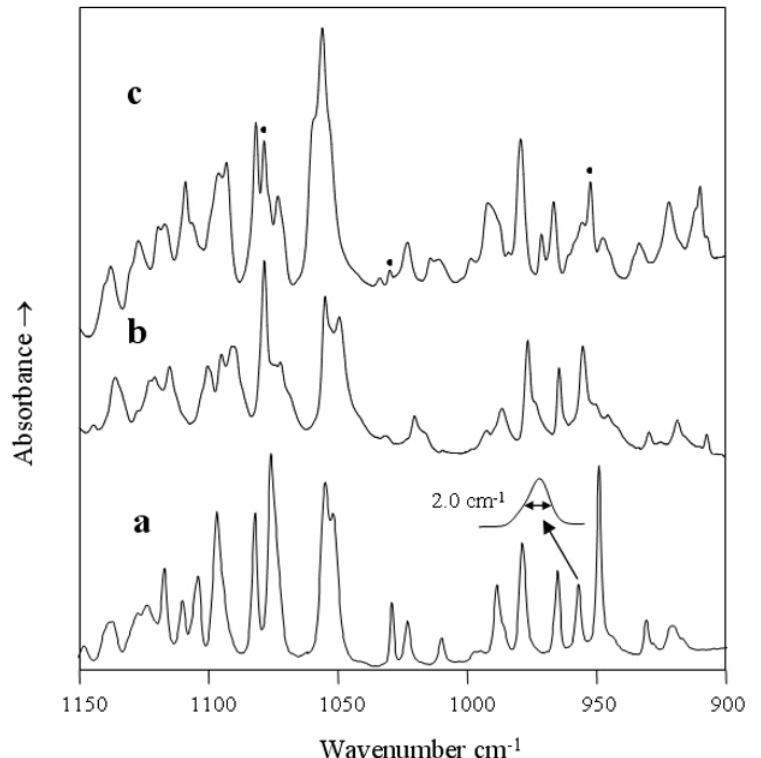
Figure 3. IR absorption spectra of 1-butene SOZ isolated in: (a) nitrogen matrix; (b) xenon matrix; (c) argon matrix. (•) denotes spectral bands of ethene SOZ. Spectral band of 1-butene SOZ isolated in nitrogen matrix are as narrow as 2 cm -1